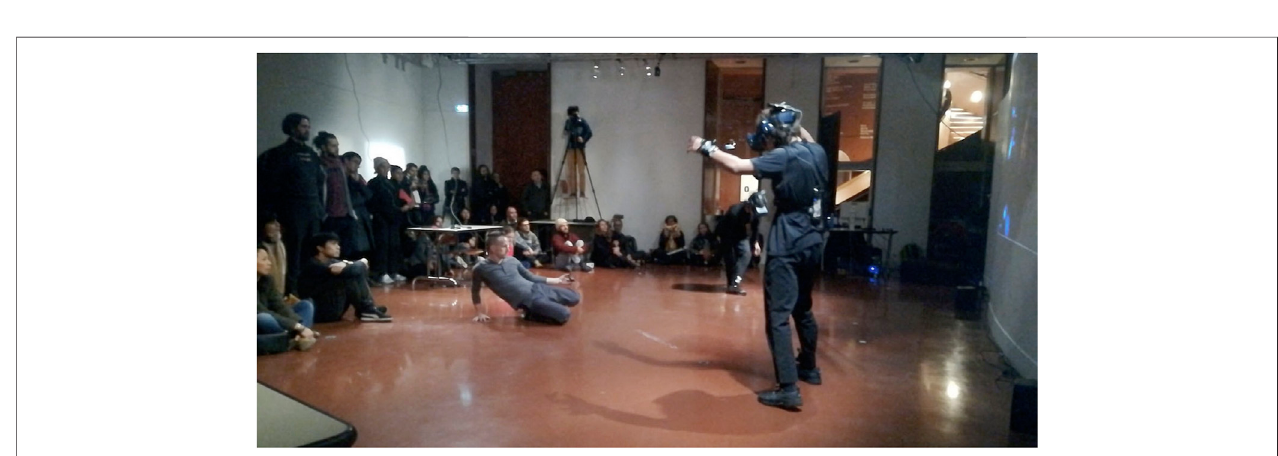
FIGURE 12 | Articulations Performance at École nationale supérieure des Arts Décoratifs, salle Rotonde (13 – 11 – 2019) with the choreographer Clint Lutes, the dancers Nassim Baddag and So fi an El Boukhari, the VR stage managers Dionysios Zamplaras and Loup Vuarnesson and the musician Baptiste Morin.